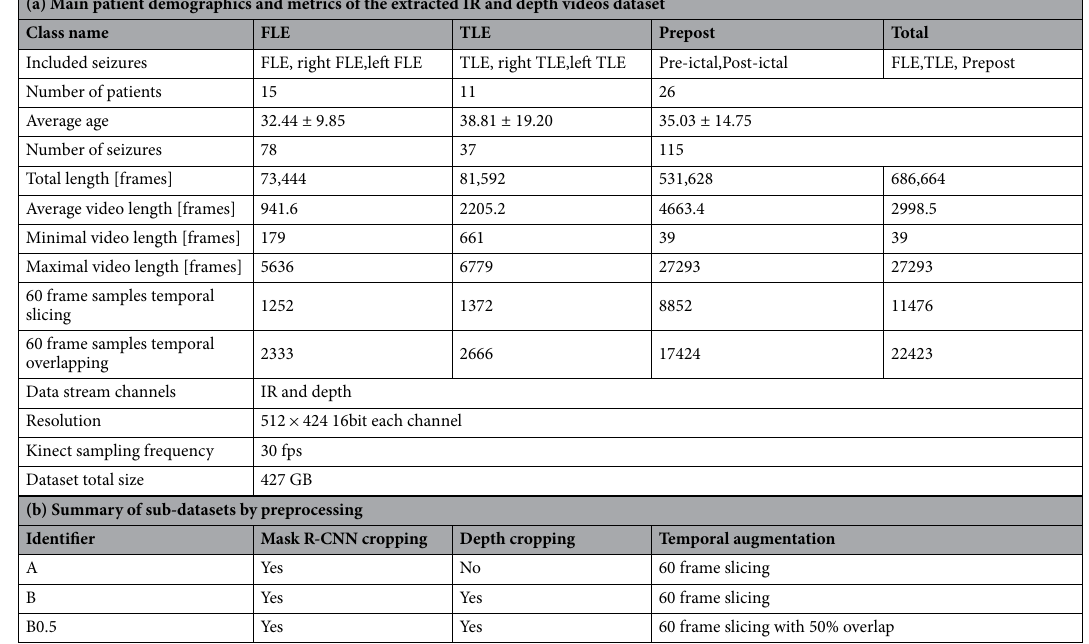
Table 3. Dataset. ( FLE frontal lobe epilepsy, TLE temporal lobe epilepsy, Prepost pre- and postictal parts of the